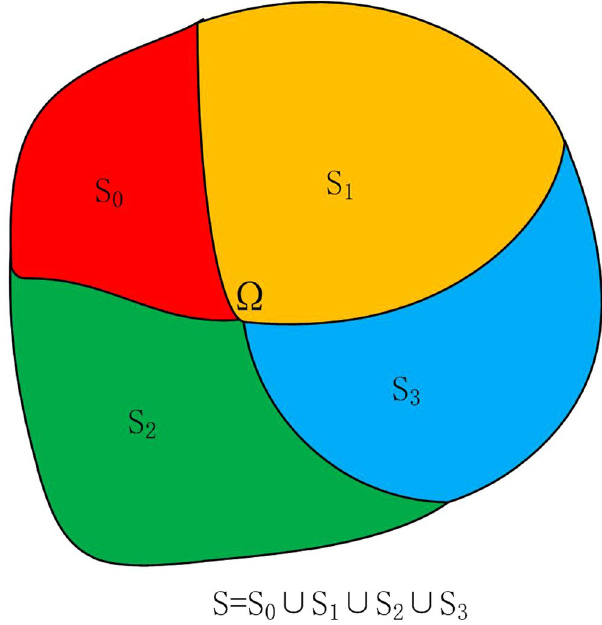
Figure 1. An arbitrarily shaped object Ω and its boundary surface S = S 0 ∪ S 1 ∪ S 2 ∪ S 3